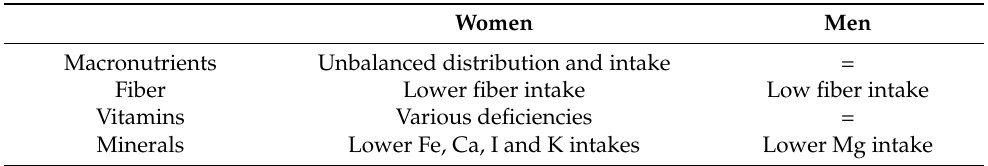
Table 4. Differences between celiac men and